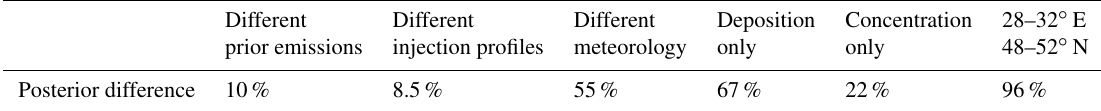
Table 2. Sensitivity of posterior total emissions to (a) different prior emissions (six different previously published assessments), (b) using different injection altitudes in the prior source term, (c) replacing the ECMWF ERA-40 with the ERA-Interim meteorological data, (d) using only deposition data or (e) surface activity concentration measurements only and (f) using both deposition and concentration observations close to the NPP (28–32 ◦ E, 48–52 ◦ N), expressed as relative differences to the reference